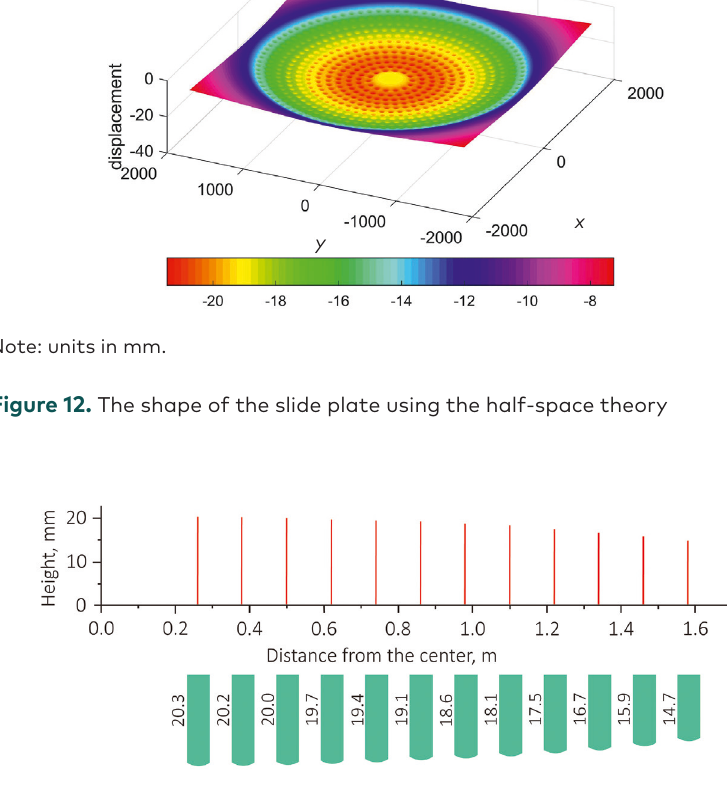
Note: from the centre to the Figure 13. Height distribution for the profile of slide plates